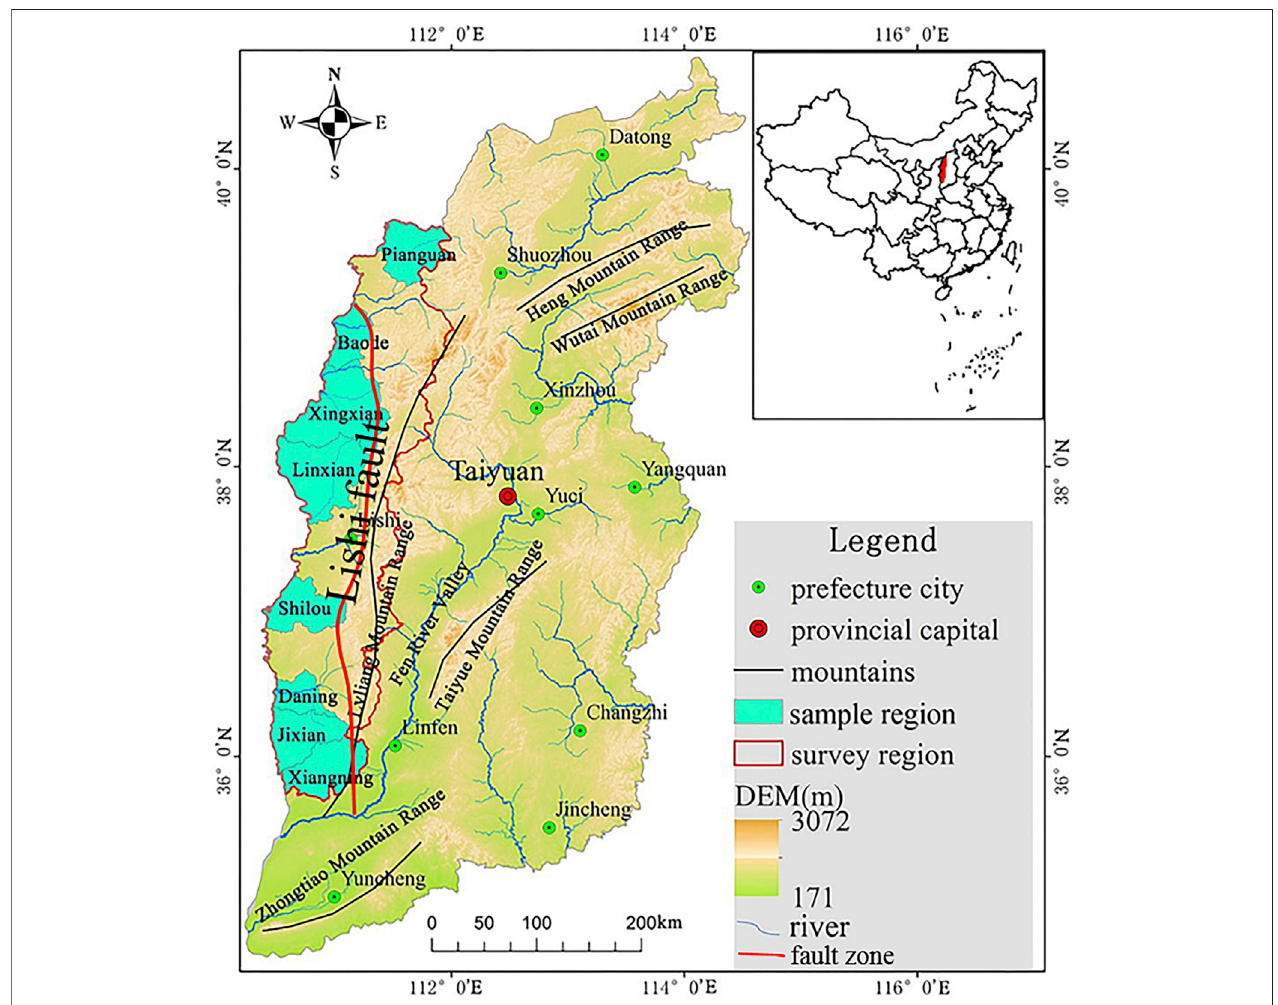
FIGURE 1 | Map of the study area in wastern Shanxi Province, China. An inset map shows the location of the study area within an outline map of other administrative areas of China.